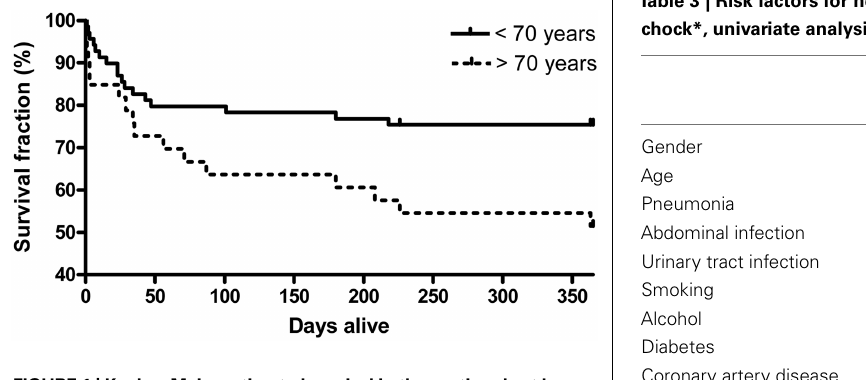
FIGURE 1 | Kaplan–Meier estimated survival in the septic cohort by age ( < 70, or 70years and older) . ( p -Value = 0.021, log-rank test, χ 2 = 5.36).